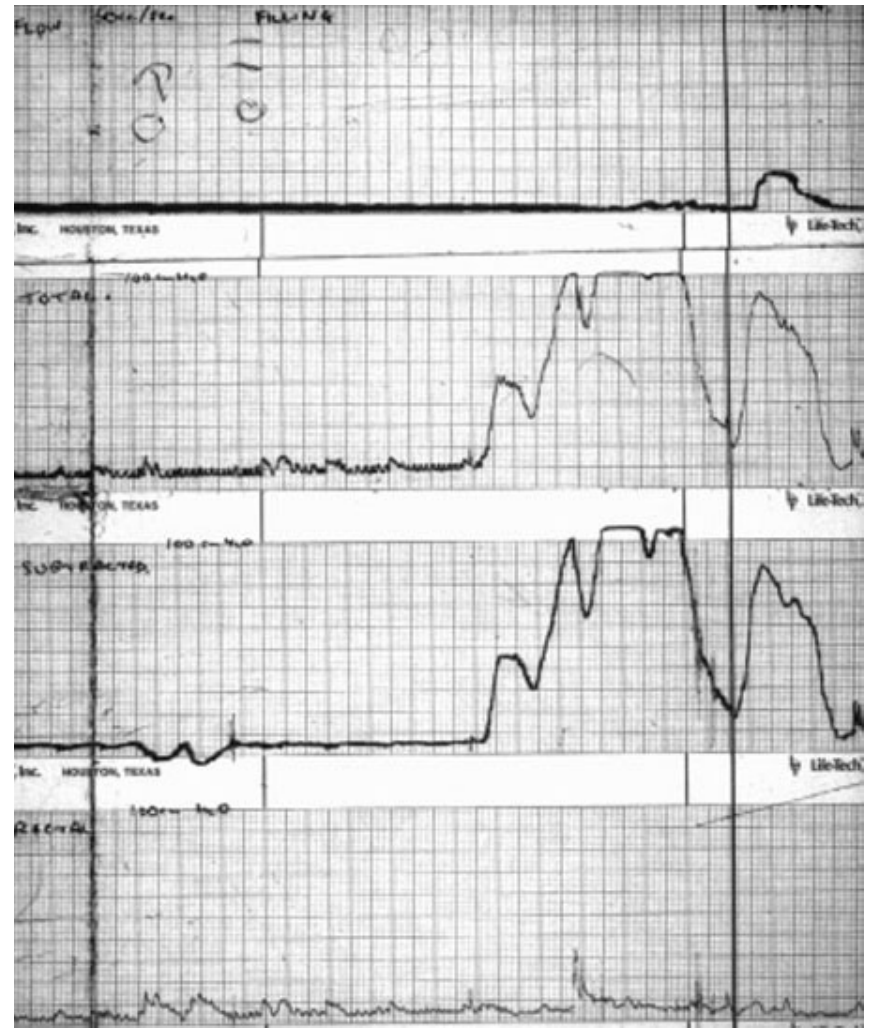
FIGURE 2. Sixty-one year old man with severe urgency, frequency, nocturia, occasional urge incontinence, and poor stream. Note high-pressure unstable contractions before voiding (>100 cm H2O). Patient voids with high detrusor pressure and low flow